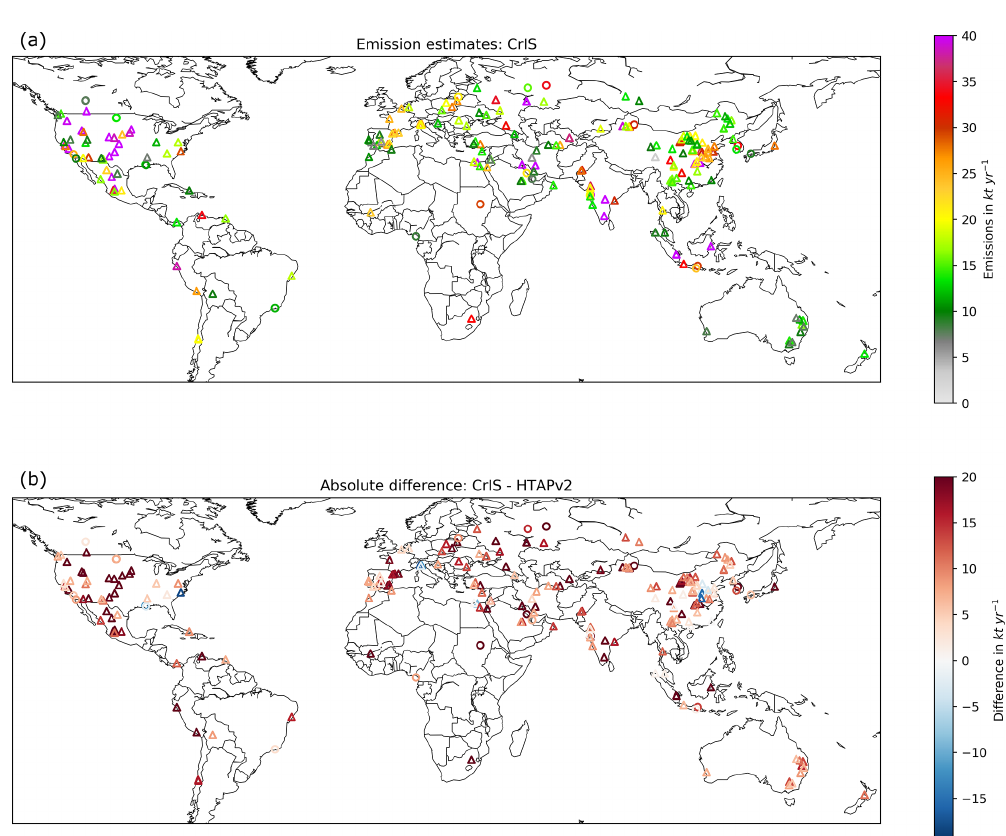
Figure 10. Global overview of CrIS emission estimates compared to the HTAPv2 inventory for locations with r > 0 . 3, SNR > 2, a fixed σ of 15km and a lifetime of 2.5h. Panel (a) shows the CrIS emission estimates and (b) the difference between the CrIS estimates and the corresponding emissions found in the HTAPv2 inventory for a square 1.00 ◦ × 0.50 ◦ (long, lat) surrounding the locations. Open triangles indicate locations with agricultural emissions equal to and above the sum of all other classes in the inventory.